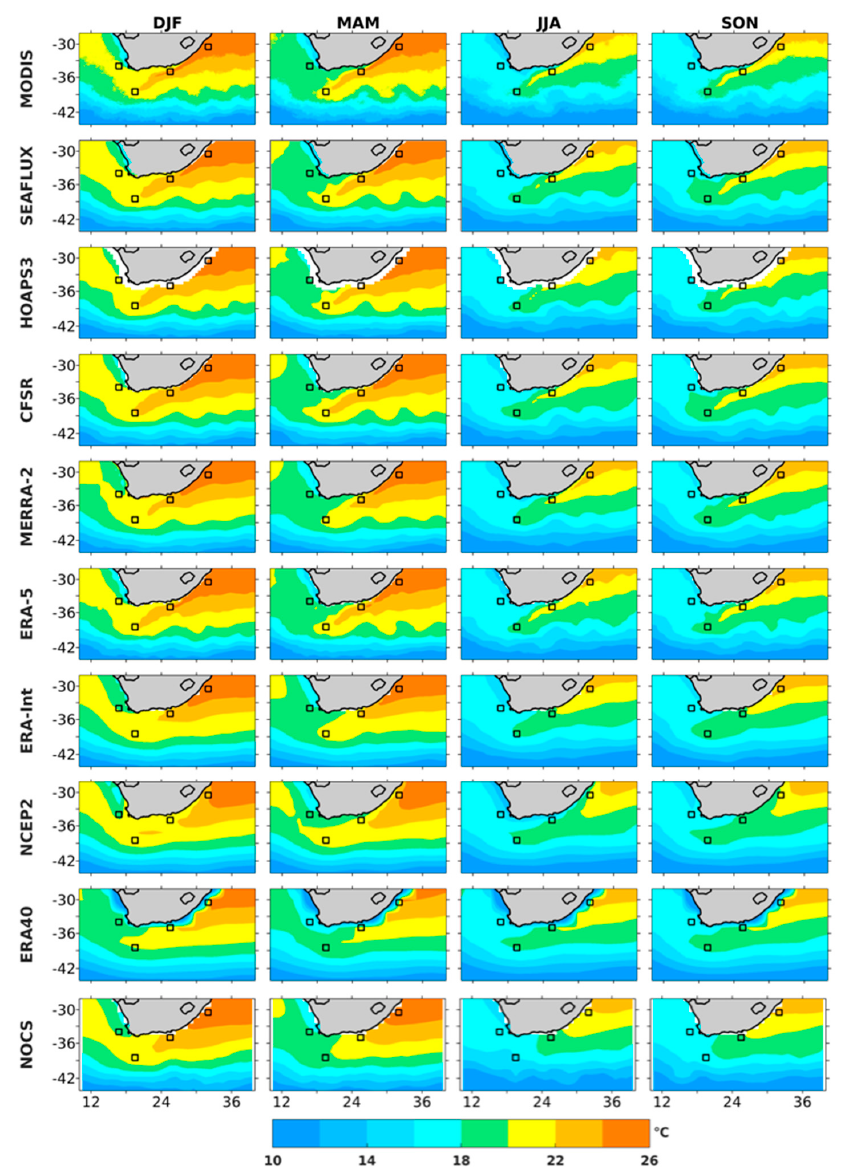
Figure 5 : From top to bottom: seasonal average of sea surface temperature SST (°C) of MODIS, SEAFLUX, HOAPS3, CFSR, MERRA-2, ERA-Interim, NCEP2, ERA-40 and NOCS. From left to right austral summer (DJF), austral autumn (MAM), austral winter (JJA) and austral spring (SON). Black squares represent the four locations taken for the study. MODIS SST is the reference for SST. The products have been interpolated on the grid of MODIS.